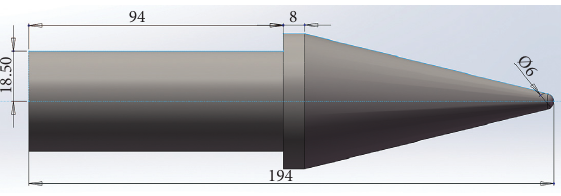
Figure 7: Size of pick model.